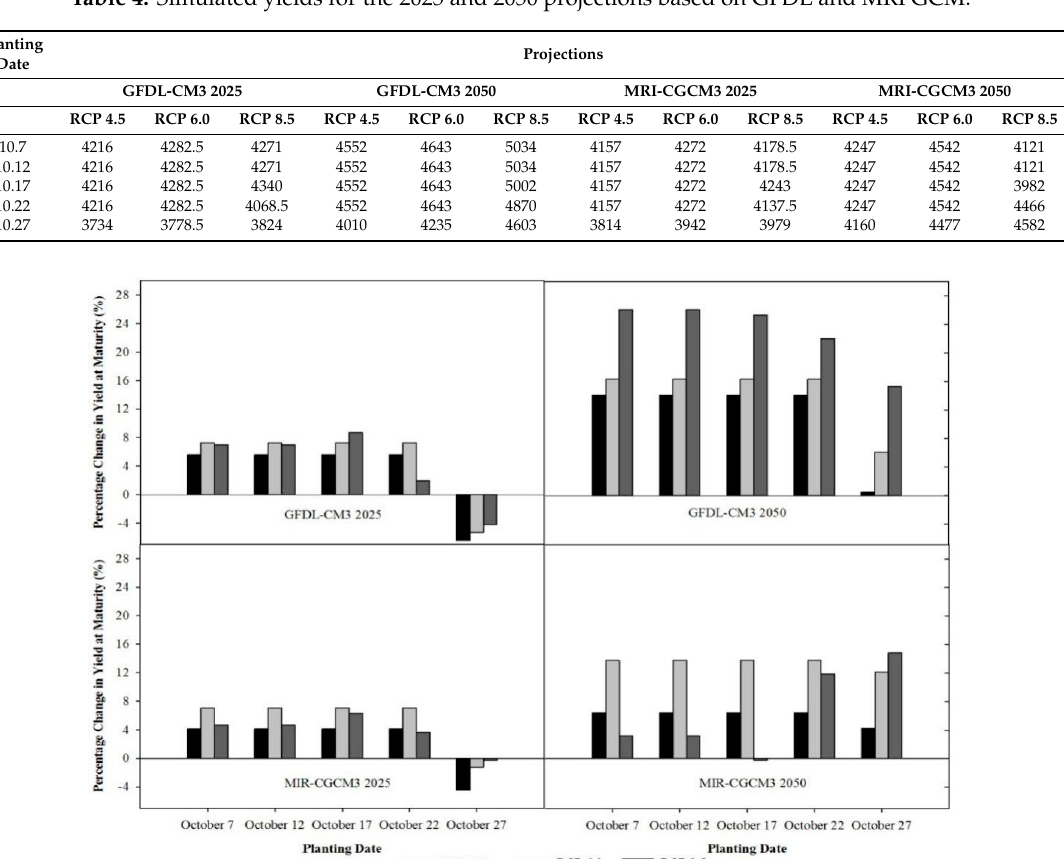
Table 4. Simulated yields for the 2025 and 2050 projections based on GFDL and MRI GCM. Planting